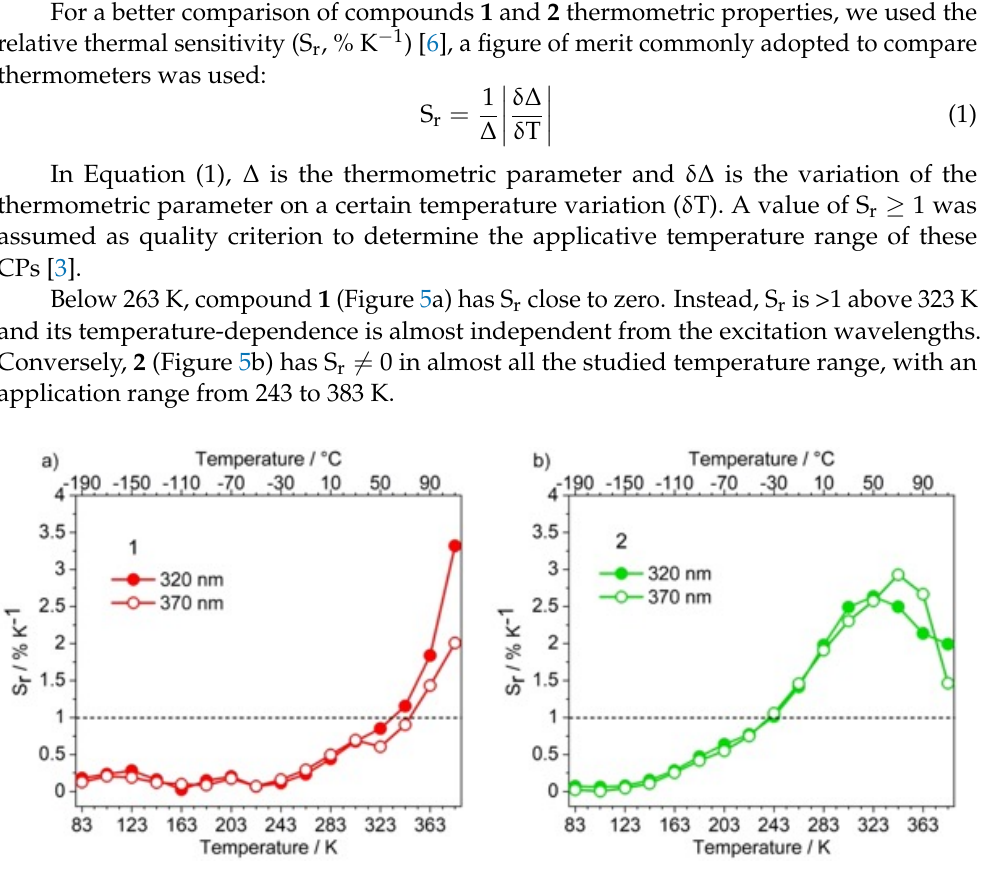
Figure 5. Comparison between the S r curves of compounds ( a ) 1 and ( b ) 2. λ exc = 320 nm ( ● ) and 370 nm ( ○